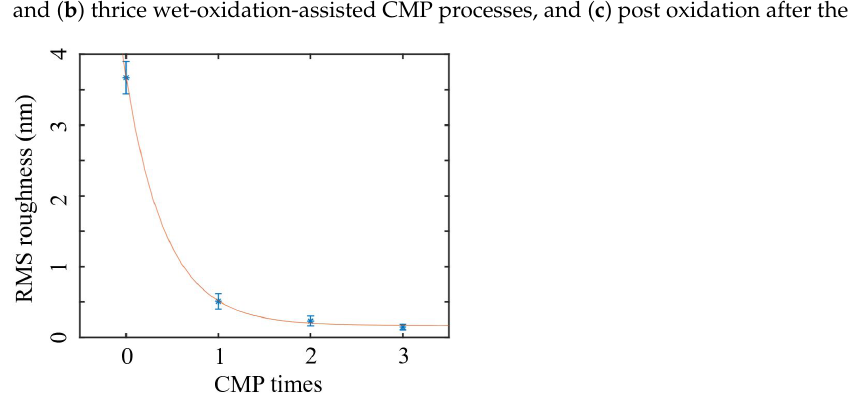
Figure 3. Surface roughness of the 4H-SiC chip versus the number of the wet-oxidation-assisted CMP